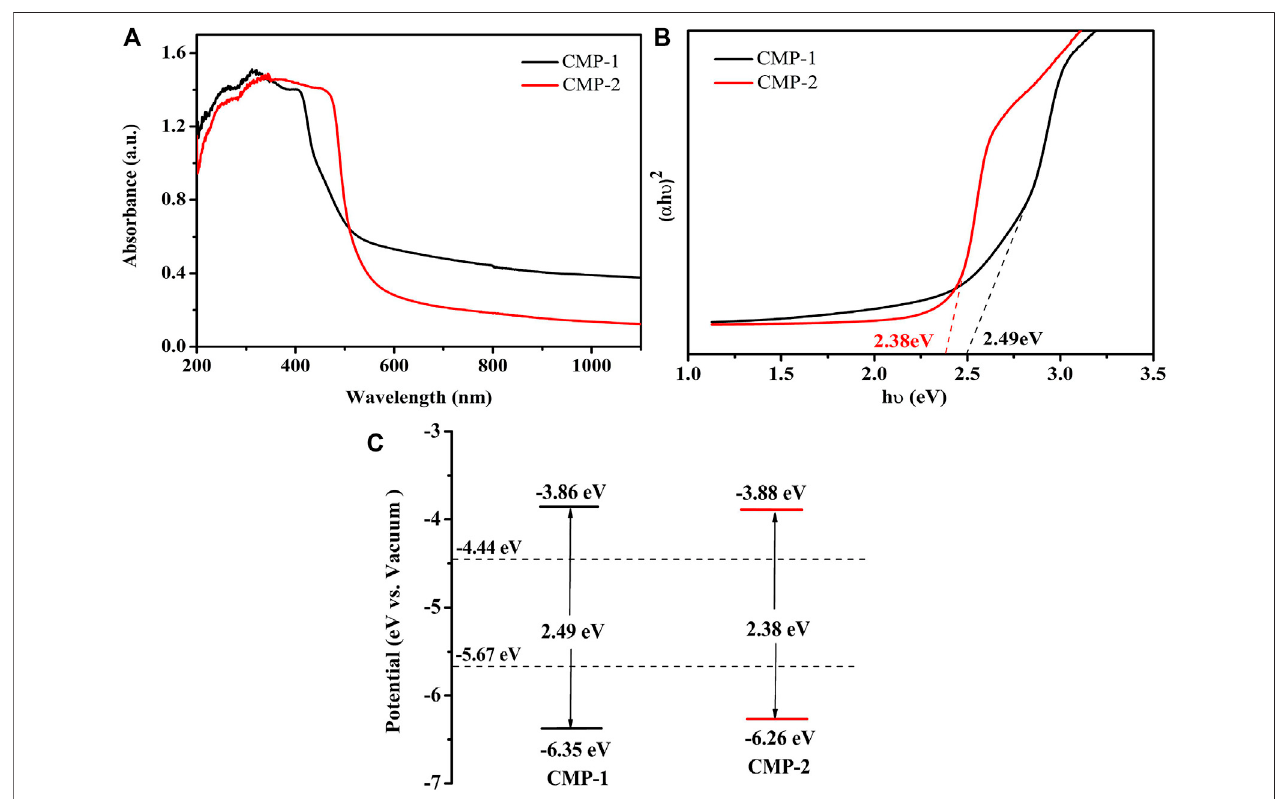
FIGURE 4 | (A) UV-vis absorption spectra of CMP-1 and CMP-2. (B) ( α hv ) 2 vs. hv curve of CMP-1 and CMP-2. (C) The band structure diagram of the CMPs.